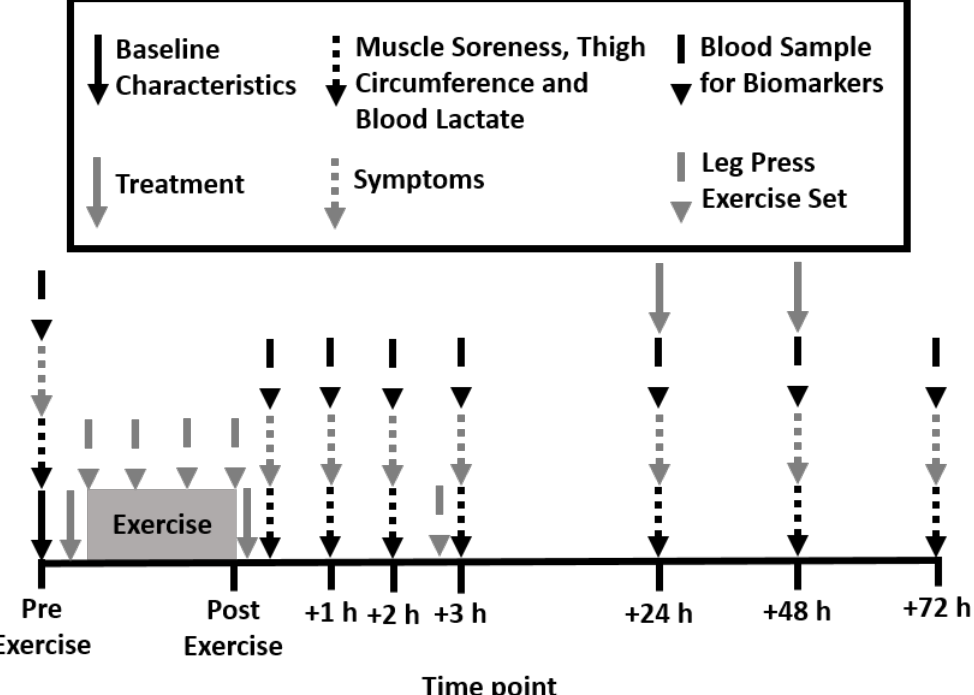
Figure 1. Schematic of experimental design.